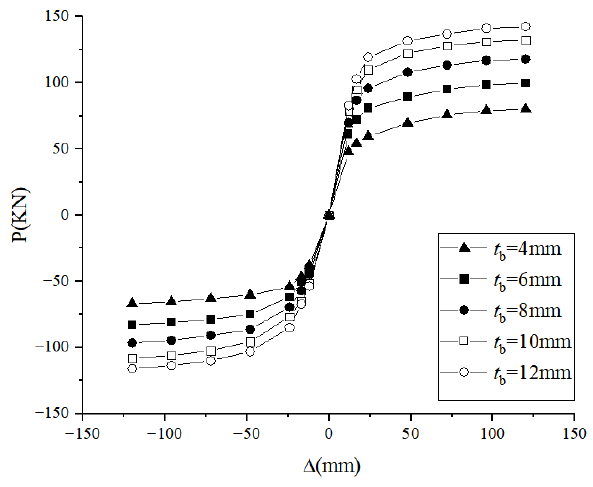
Figure 19. Thickness of U-shaped steel.